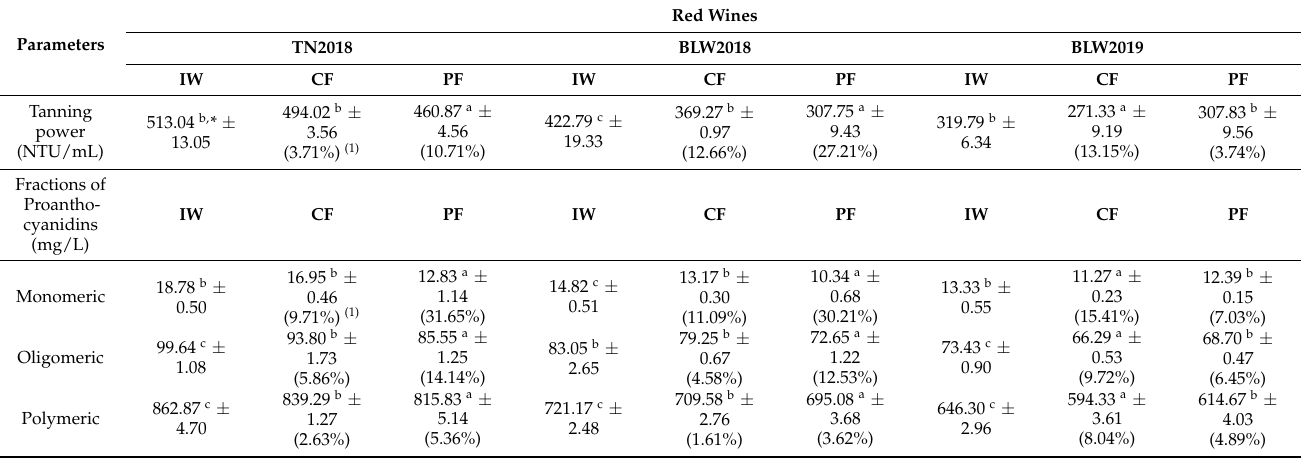
Table 4. The impact of the two different filtration techniques on the tanning power and different fractions of proanthocyanidins for the three red wines